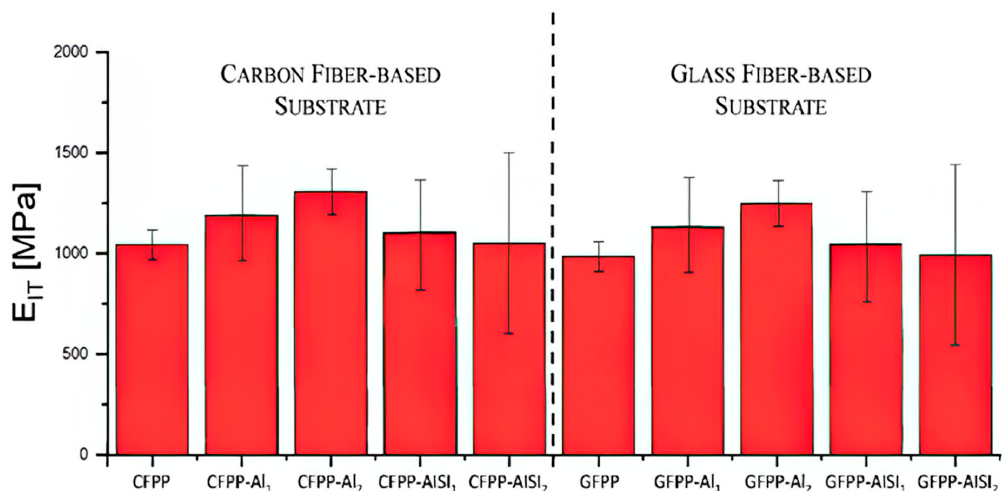
Figure 6. Confocal microscope results showing exemplificative roughness profiles for both coated and uncoated area of CFPP-Al 1 sample.